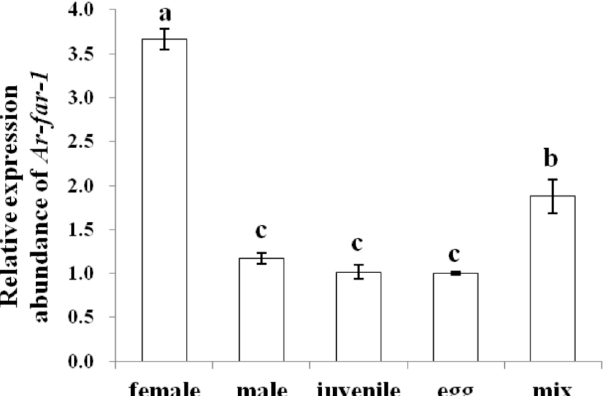
Figure 6. Relative expression of Ar-far-1 in the mixed-stage nematodes and at different development stages of Aphelenchoides ritzemabosi. Mix: mixed-stage nematodes. Bars indicate standard errors of the mean ( n = 3), and the same letters indicate no significant difference ( p > 0.05) between treatments according to Duncan’s multiple range test.